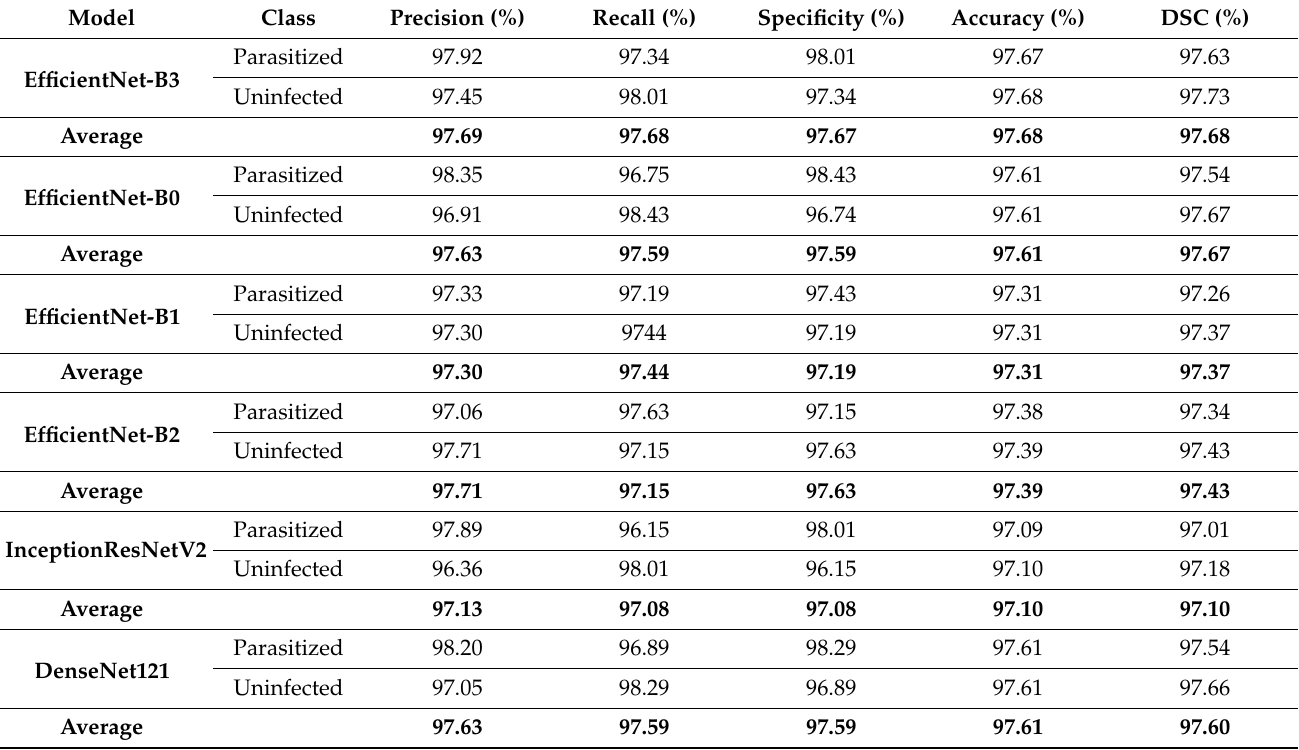
Table 6. The performance of binary classification of malaria parasites for the six CNN models using the proposed dynamic LR.